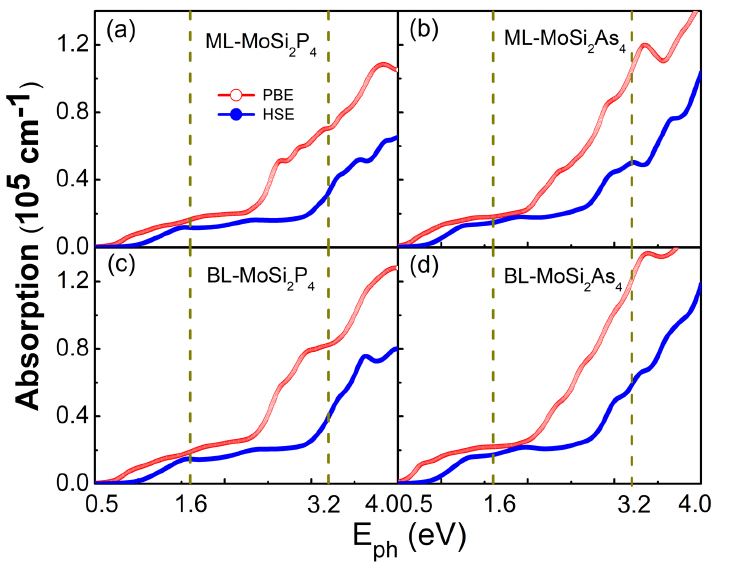
Figure 6. Optical absorption coefficients versus the energy of incident light for 2D ( a ) monolayer MoSi 2 P 4 , ( b ) monolayer MoSi 2 As 4 , ( c ) bilayer MoSi 2 P 4 and ( d ) bilayer MoSi 2 As 4 based on PBE and HSE06 functionals. For each panel, the polarization vector of incident light is set parallel to the plane, and the two vertical dashed lines indicate the region of visible light.